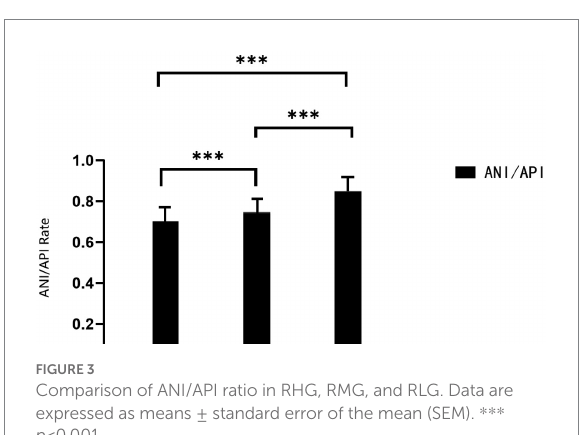
FIGURE 3 Comparison of ANI/API ratio in RHG, RMG, and RLG. Data are expressed as means ± standard error of the mean (SEM). *** p <